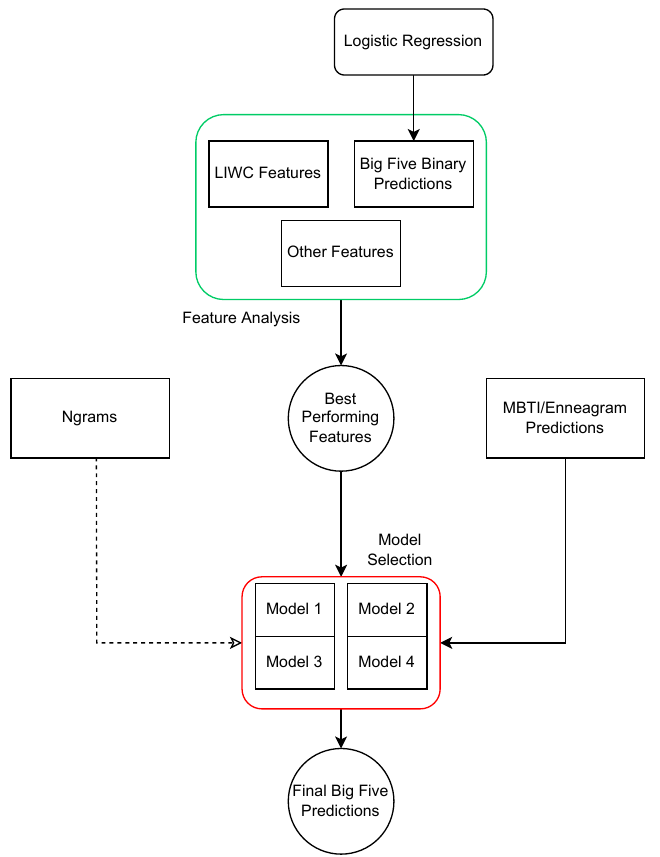
Figure 9. Simplified illustration of the pipeline behind our method. The green rectangle depicts feature selection approaches, while the red one highlights the model selection